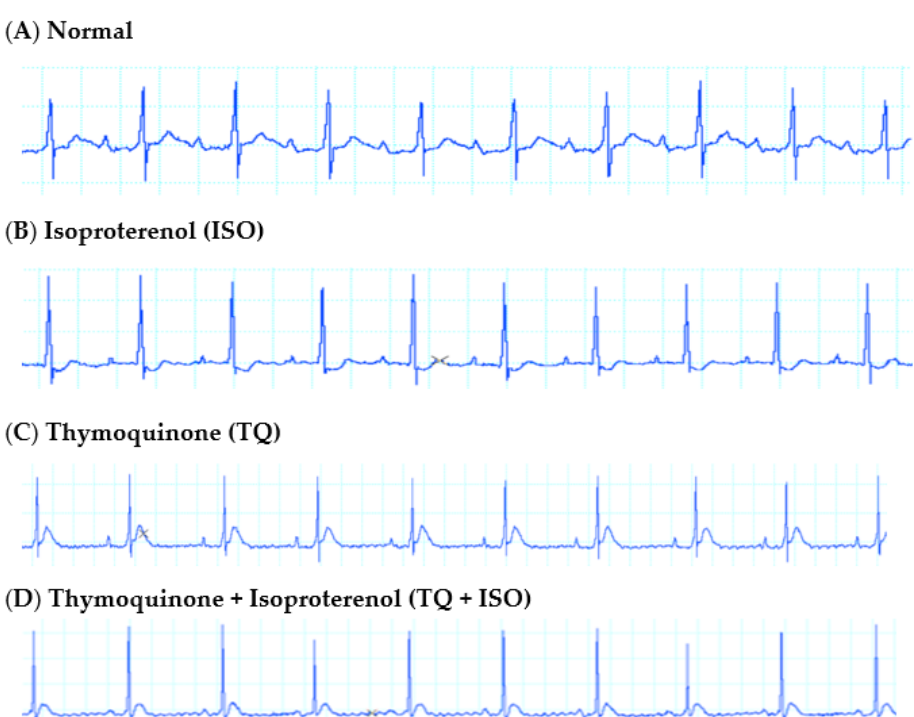
Figure 3. Representative lead II ECG tracings from rats receiving vehicle ( A ) normal; ( B ) ISO; ( C ) TQ; ( D ) TQ + ISO.